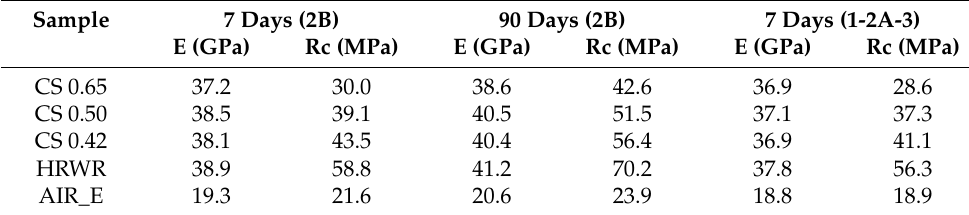
Table 2. Mechanical properties of the investigated materials * (Procedures 2B and 1-2A-3).